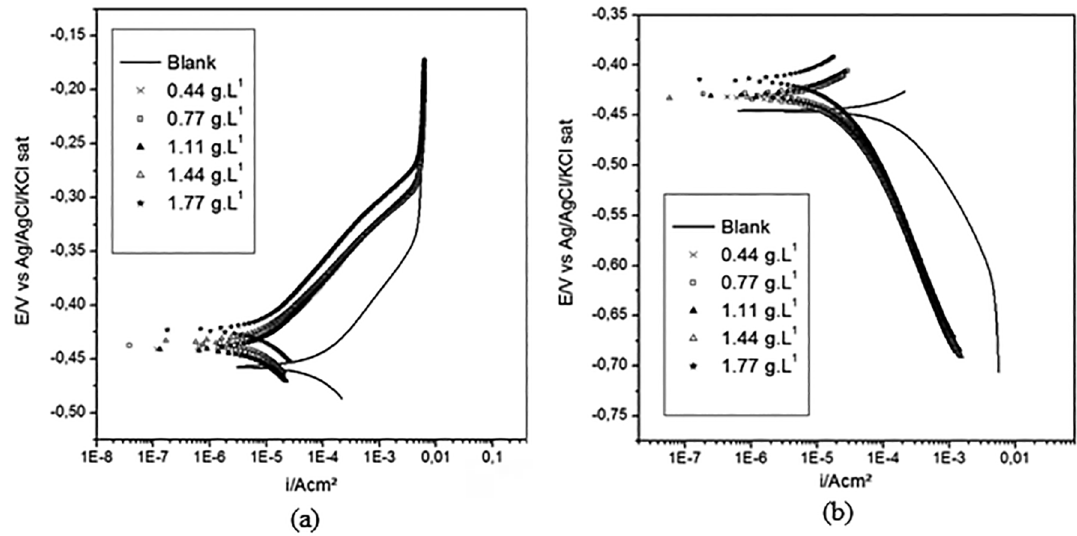
Figure 5. Potentiodynamic polarization curves for AISI 1020 carbon steel in 0.5 mol.L -1 HCL solution in the absence and presence of different amounts of castor bark powder: anodic (a) and cathodic (b)